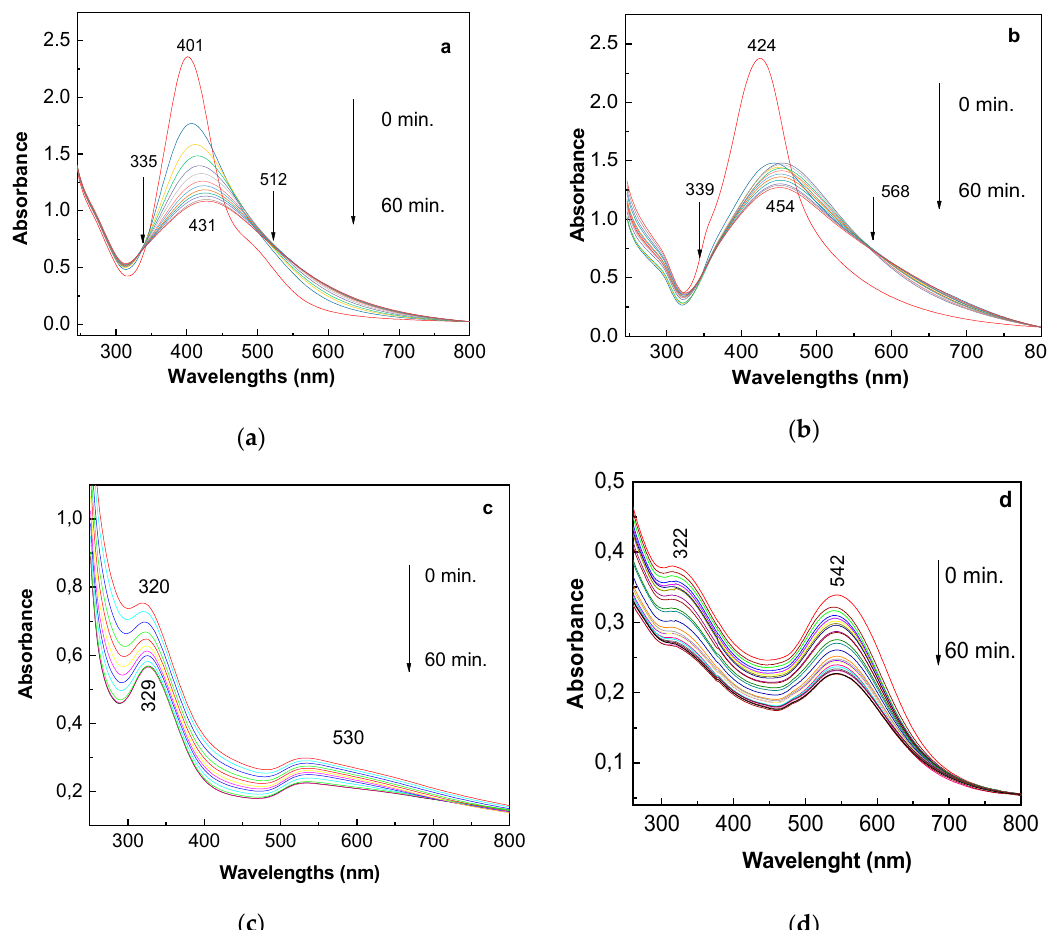
Figure 4. UV-VIS spectra of ALA in the presence of Ag with a particle size of 5 nm ( a ), Ag with a particle size of 10 nm ( b ), Au with a particle size of 5 nm ( c ), and Au with a particle size of 10 nm ( d ). The concentration of ALA is 1 mg / mL. The four samples’ UV-VIS spectra were recorded at intervals of 5 min of exposure to UV light, for 60 min.